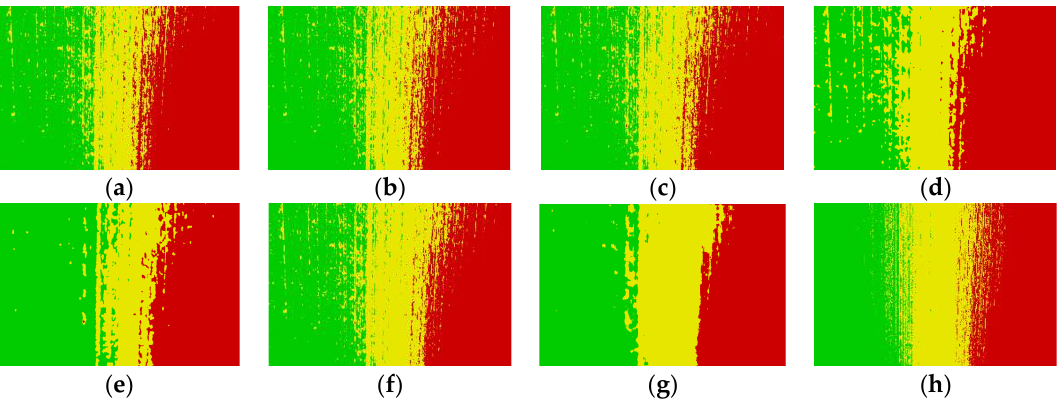
FCM_SNLS result, ( g ) CKS_FCM result, ( h ) FCM_NNS result. result, ( g ) CKS_FCM result, ( h ) FCM_NNS result.